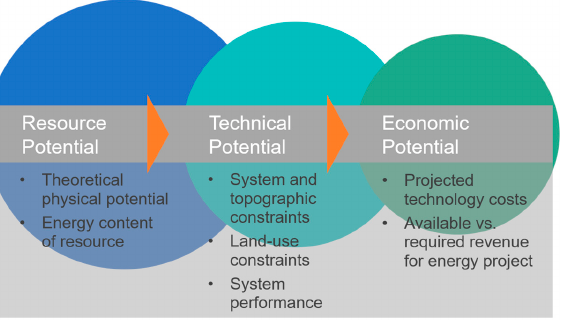
Figure 1. Three types of renewable generation potential (traditional ratio) [3].